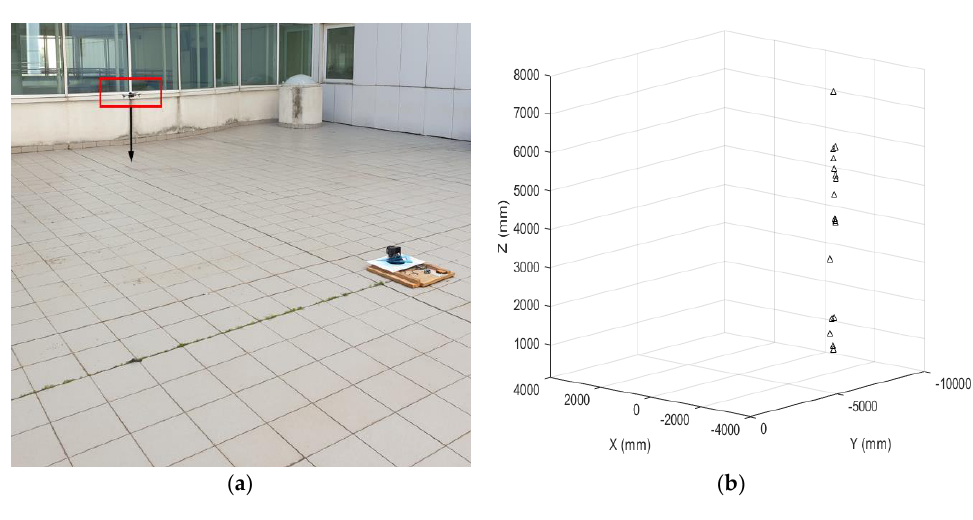
Figure 22. ( a ) UAV landing path; ( b ) Reconstruction from LiDAR data.